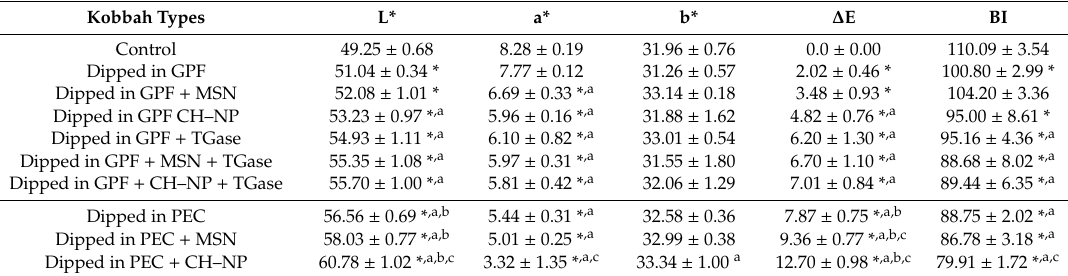
Table 3. Color properties of fried kobbah coated with di ff erent hydrocolloid-based